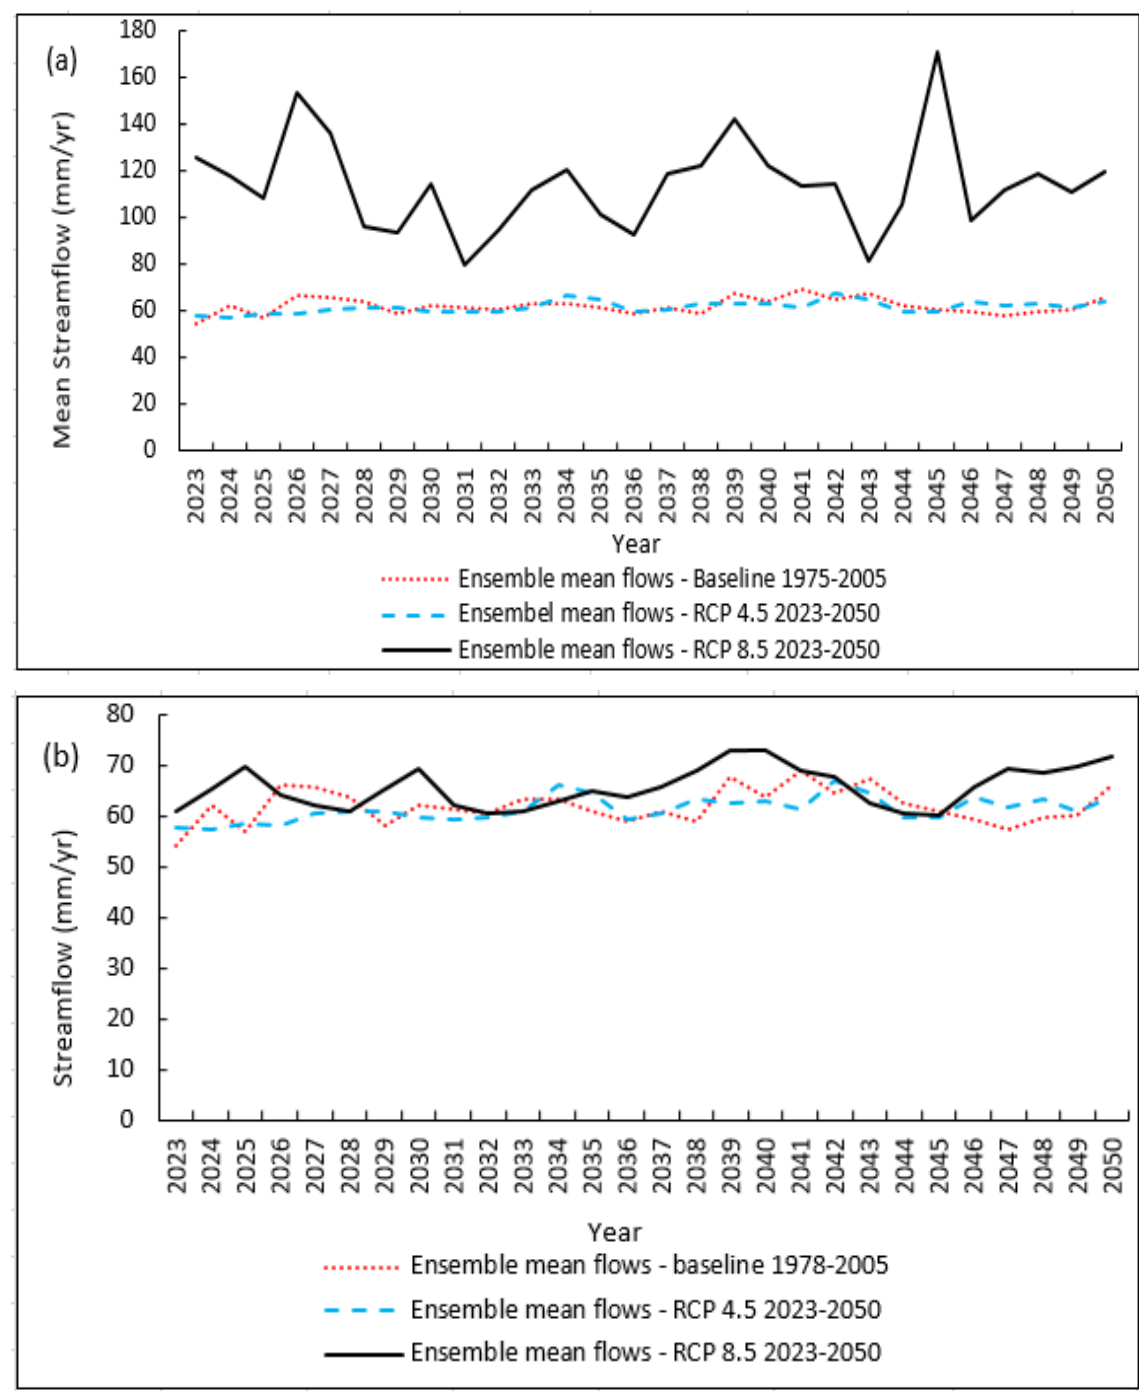
Figure 9. Ensemble mean annual flows for ( a ) high uncertainty; and ( b ) strong consensus.